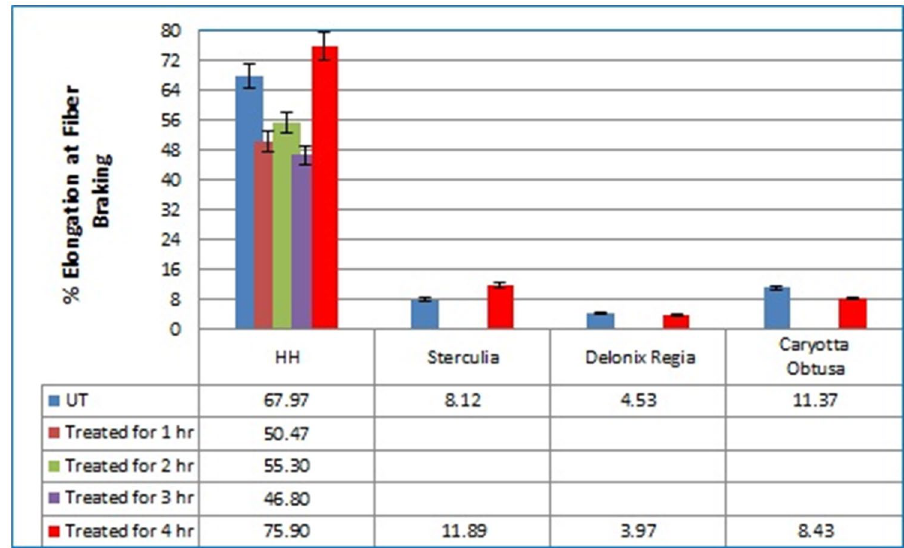
Fig. 10 Percentage elonga- tions of untreated and treated natural fibers at breaking